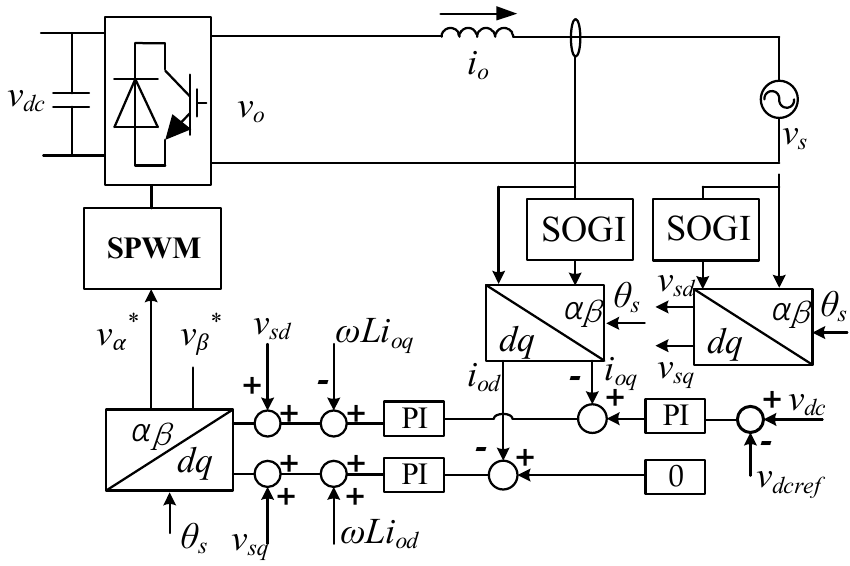
Figure 6. Block diagram of PQ control strategy with DC voltage as outer loop.